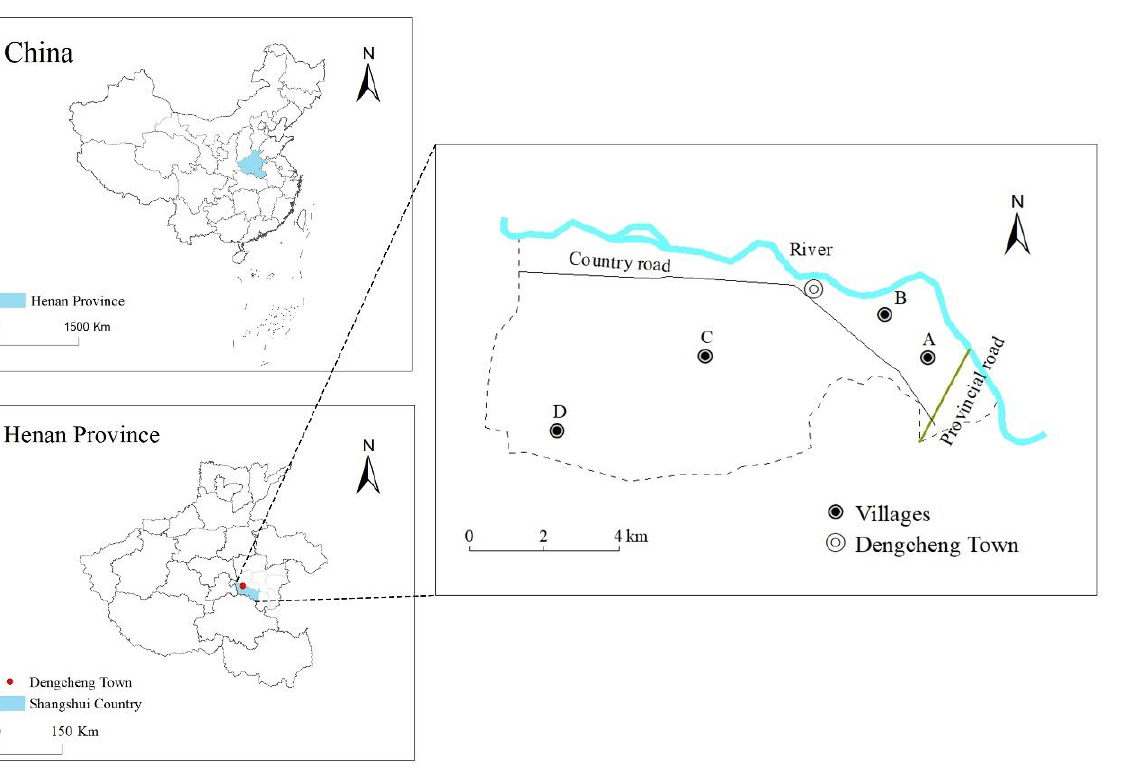
Figure 1. Location of the Study area.